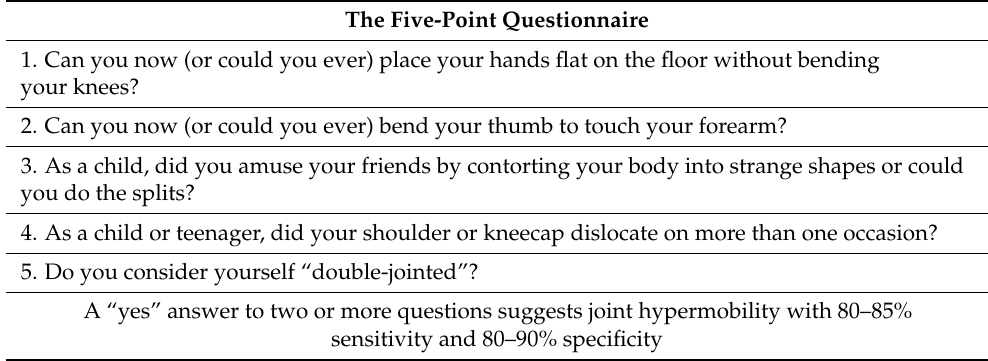
Table 3. The Five-Point